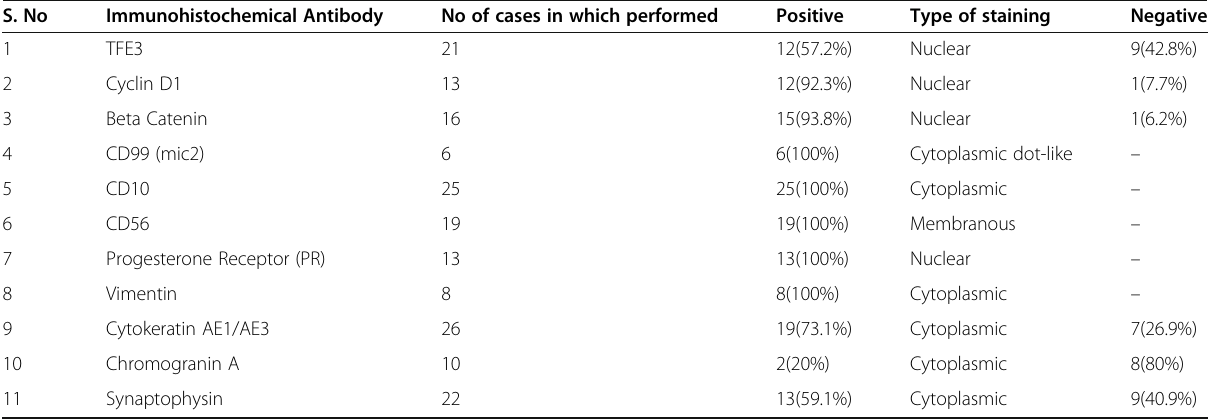
Table 3 Immunohistochemical profile of SPN cases in patients under 20 years of age ( n = 29) S. No Immunohistochemical